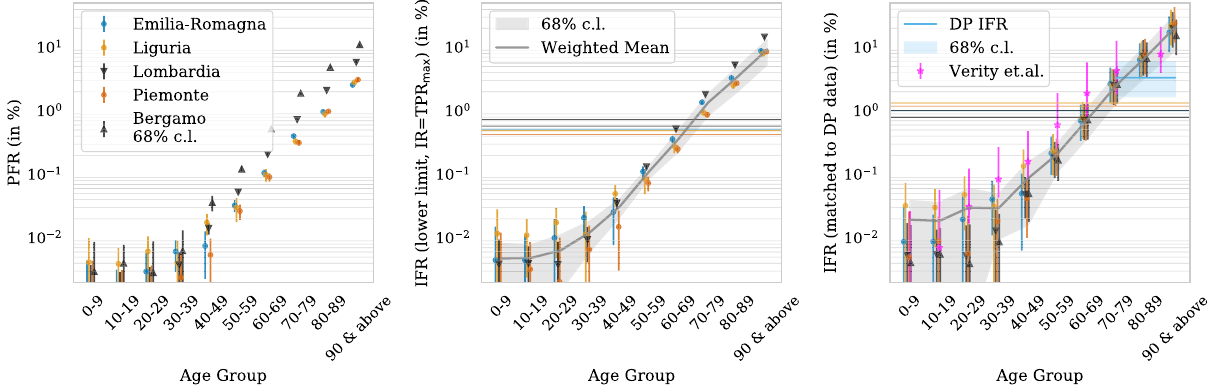
Fig. 5 Fatality rates for different age groups and regions. (Left) Population fatality rate (PFR) from the cumulative estimates divided by the regional population. (Center) Lower bounds on infection fatality rate (IFR) using the maximum test positive rate (TPR) as an upper bound on infection fraction. (Right) Estimates of the true IFR when normalizing the age 70 – 89 group to the Diamond Princess IFR (in shaded blue, with the corresponding Poisson error estimate). We also show estimates from Verity et al. 5 with corresponding (68% CI). in magenta, which gives less steep age dependence. In the center and right panel, the gray lines are weighted mean estimates for IFR with 1 sigma weighted standard deviation bands. The horizontal lines are the age-averaged IFR for the entire population. Error bars for all the regions and age groups are 1 − σ (68% CI) error from the variance of the Gaussian model combined with Poisson errors based on number of deaths that differs for every region and age group. In all panels, we have staggered the points horizontally for every age group for better visibility.